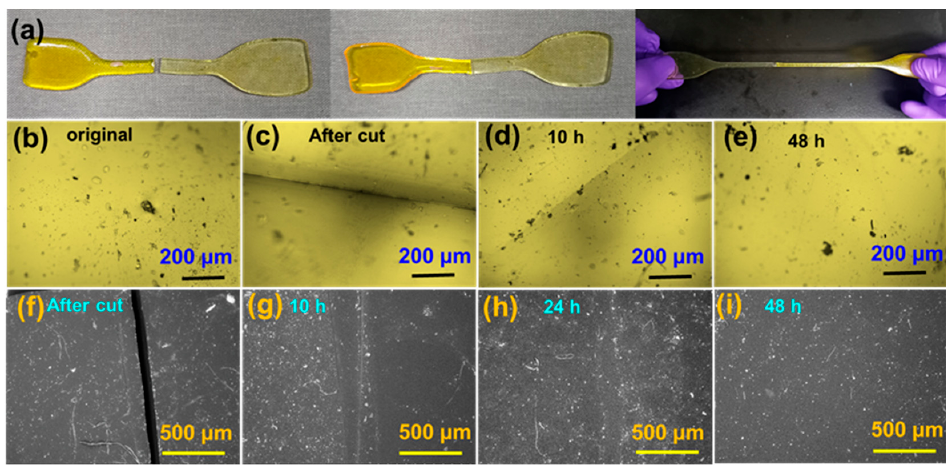
Figure 7. ( a ) Photographs of cut and self-healed PA samples; ( b – e ) POM images and ( f – i ) SEM images of cut and self-healed PA36,IA samples.